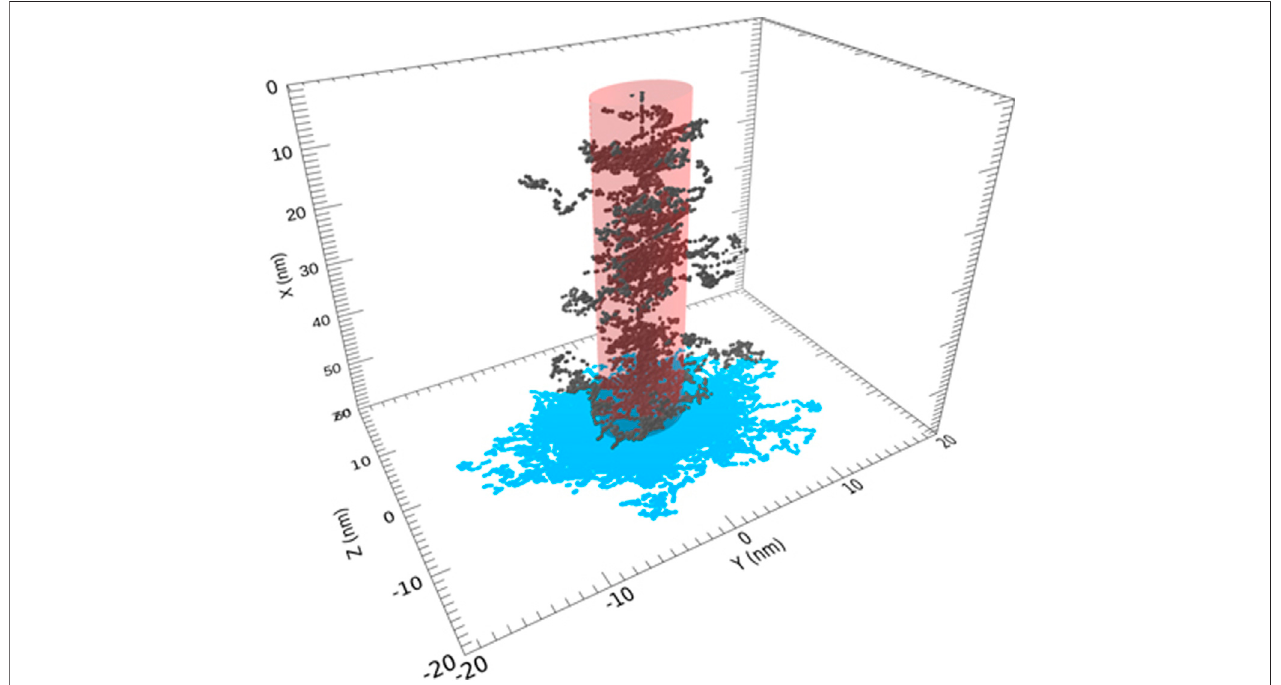
FIGURE 6 | Portion of the track for a 0.1 MeV proton and secondary electrons within the cylindrical region of amorphous ices is shown. The incident ion enters through the center of the top surface. Permission requested to reproduce this fi gure, originally appearing as Figure 2 of Shingledecker et al.